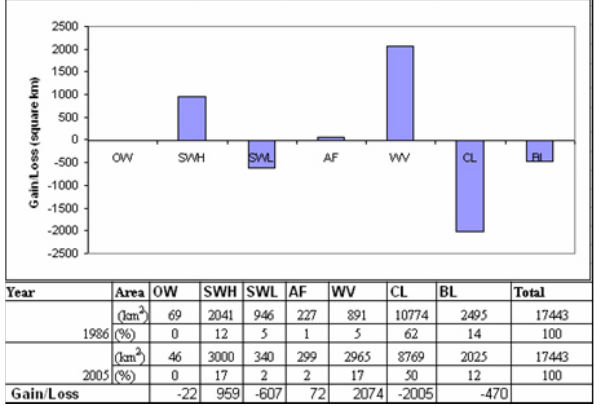
Fig. 3. Proportions of land cover types in 1986 and